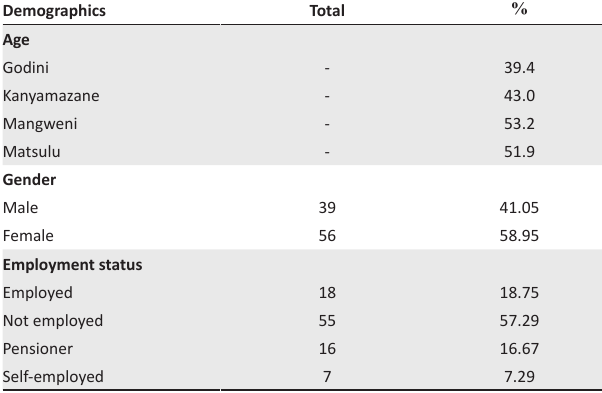
TABLE 1: Respondents’ demographic